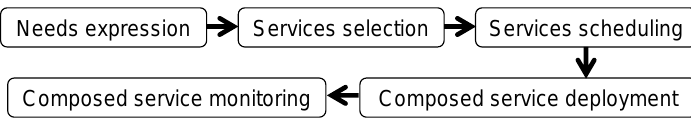
Figure 5. Illustration of the composition process